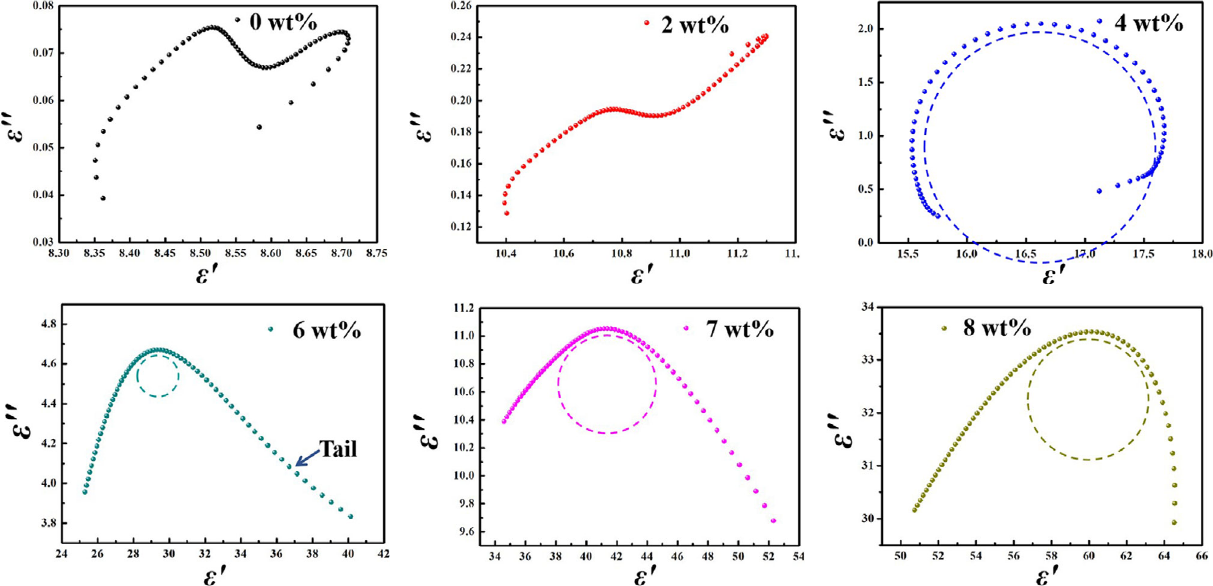
Fig. 15 ε ″ – ε ′ curves of SG/AlN composites with different SG